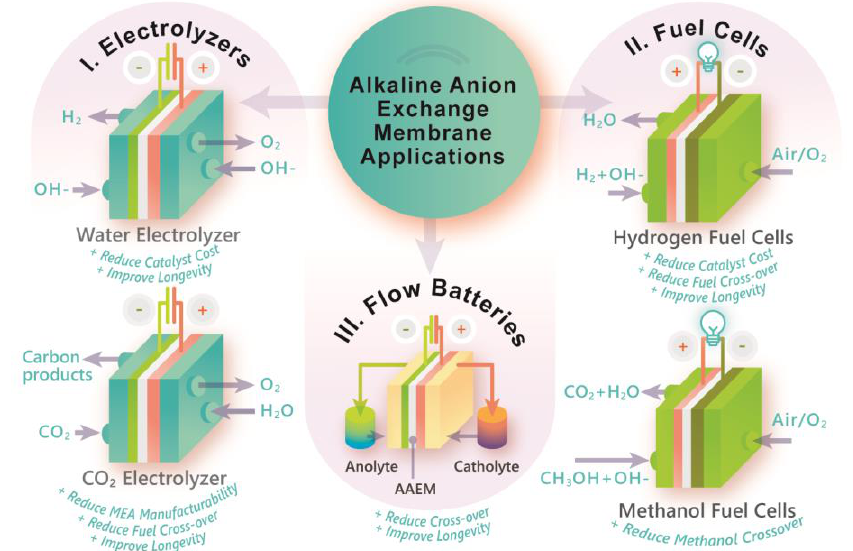
Figure 1. Depiction of the electrochemical system applications related to AAEMs and key shortcom- ings (cyan) that could improve by incorporating crosslinked AAEMs. ings (cyan) that could improve by incorporating crosslinked